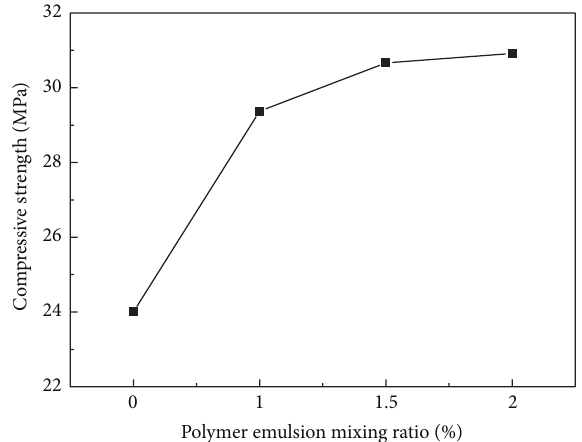
Figure 2: The relationship between compressive strength and polymer emulsion mixing ratio.